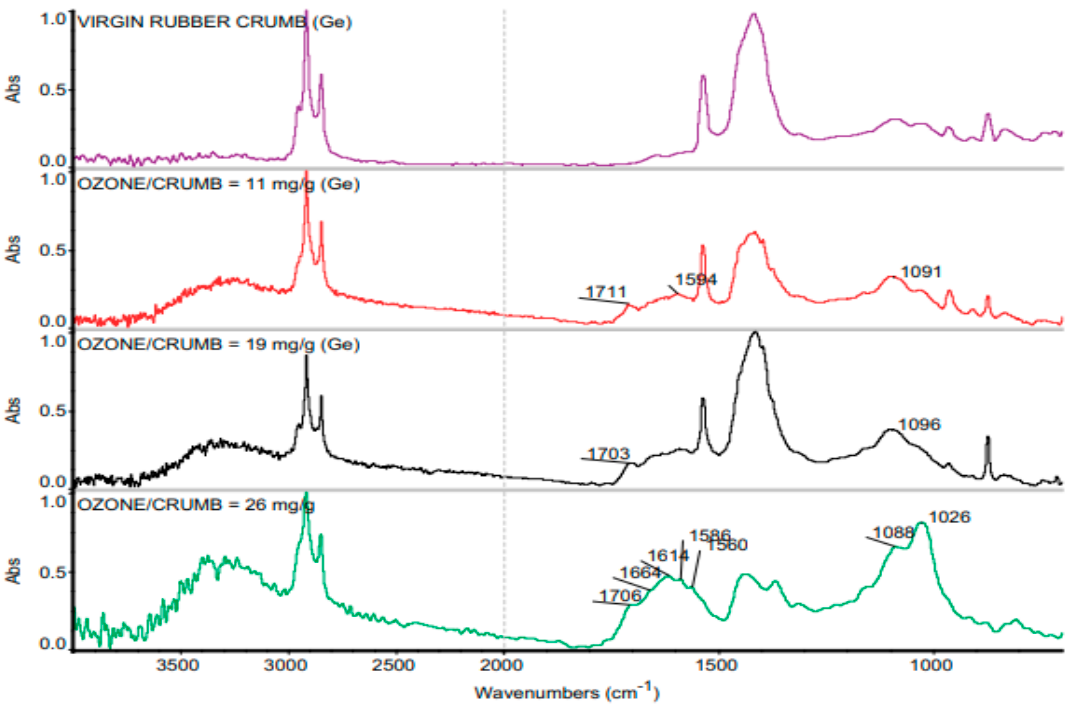
Figure 8. FTIR spectra of rubber crumb with different levels of oxidation. From top to bottom, the spectra were taken on pristine GTR for ξ oxy = 11, 19 and 26 mg/g, respectively (reproduced with permission from [80]).